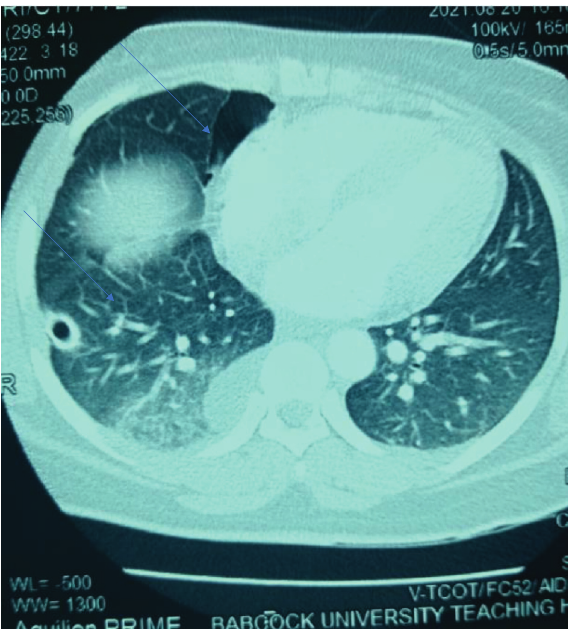
Figure 5: Chest CTscan of the chest of the patient showing a near- complete expansion of right lung (90–95%) with mild right-sided residual effusion and no obvious parenchymal lesion